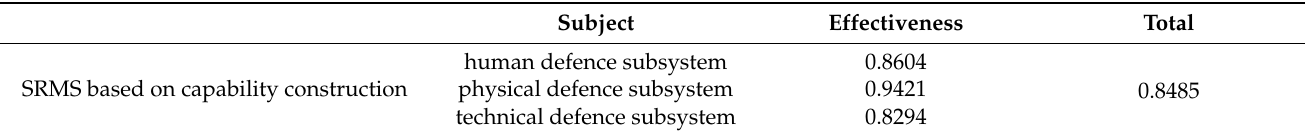
Table 15. Effectiveness value based on the entropy of capability construction.